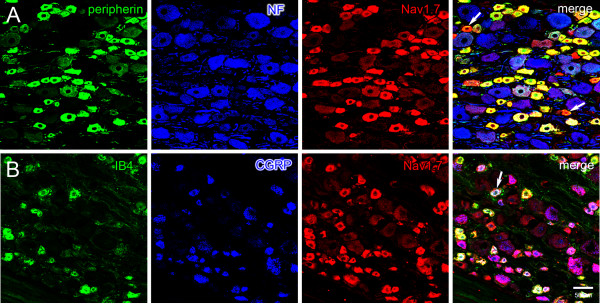
Expression of Nav1.7 in DRG neurons. A. DRG sections were reacted to antibodies against peripherin, neurofilament 200 (NF) and Nav1.7. Peripherin-positive (green) neurons are generally of small diameter (<30 μm) and most exhibit colocalization (yellow) with Nav1.7 (red). A few small peripherin-negative neurons display robust Nav1.7 immunolabeling (arrows). Neurofilament 200 (NF)-positive (blue) neurons are generally larger than peripherin-positive cells and most do not display colocalization with Nav1.7. A few smaller NF-positive cells exhibit Nav1.7 immunolabeling (magenta). B. DRG sections were reacted with IB4-488 and antibodies to CGRP and Nav1.7. Virtually all IB4-positive (green) neurons display colocalization (yellow) with Nav1.7. Similarly, nearly all CGRP-positive (blue) neurons exhibit colocalization (magenta) with Nav1.7 (red). Few DRG neurons (arrow) display colocalization of IB4, CGRP and Nav1.7.